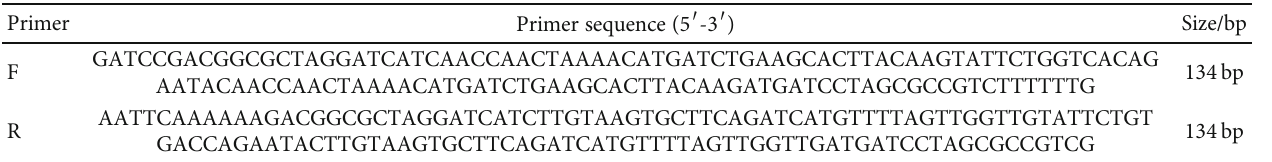
Table 2: shRNA oligo primer sequences for